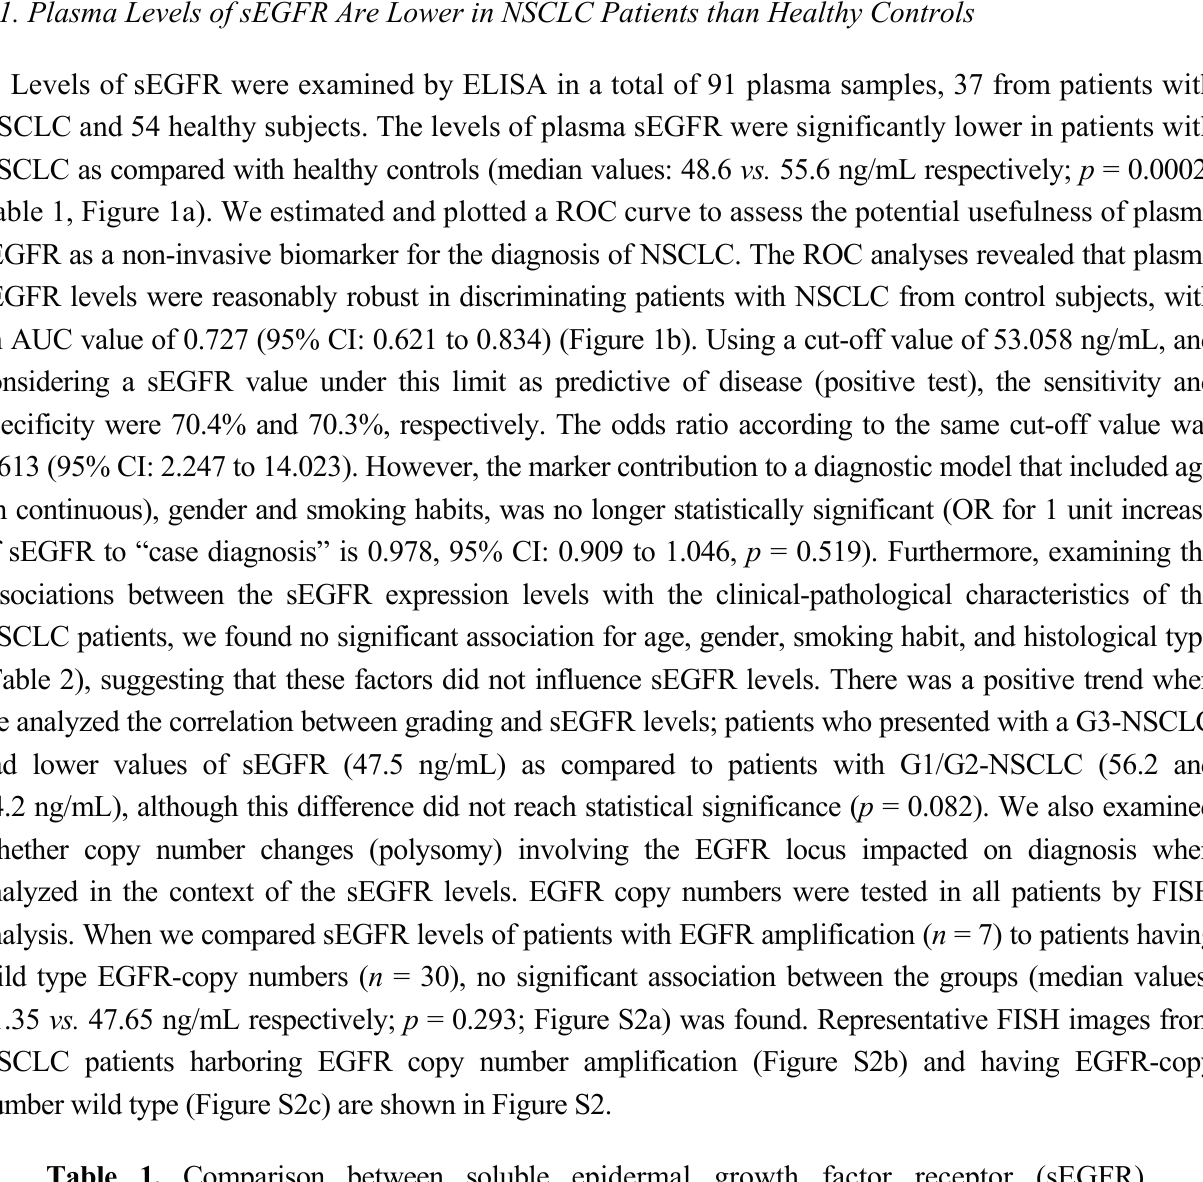
Table 1. Comparison between soluble epidermal growth factor receptor (sEGFR) concentration in non-small cell lung cancer (NSCLC) patients and healthy subjects.